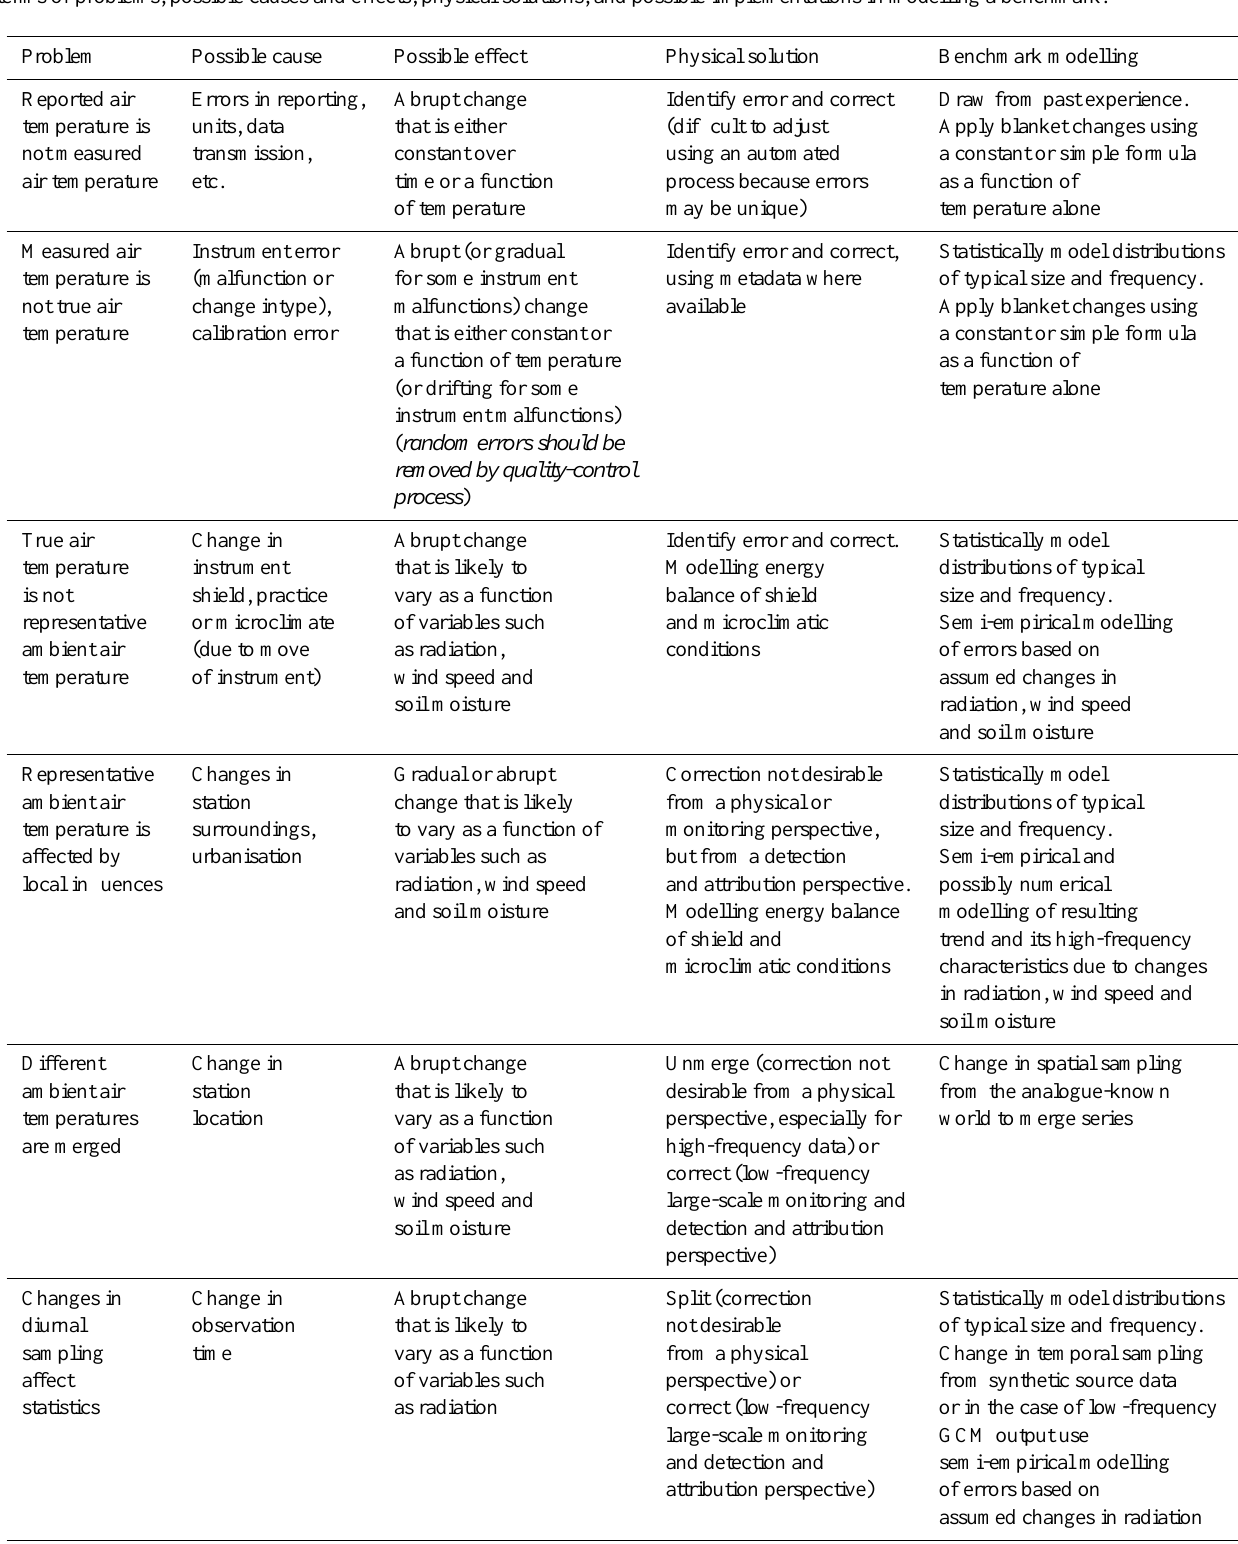
Table 1. Known inhomogeneities between observed air temperature and the ambient air temperature representative of a given location in terms of problems, possible causes and effects, physical solutions, and possible implementations in modelling a